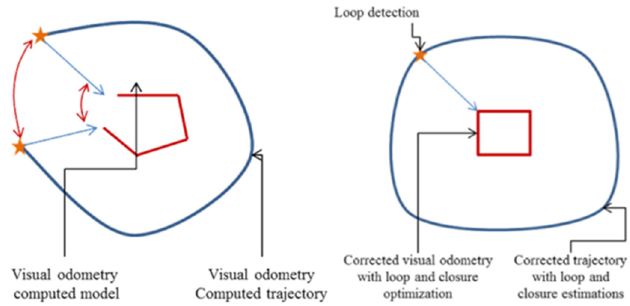
Fig. 4. Loop and closure optimization.